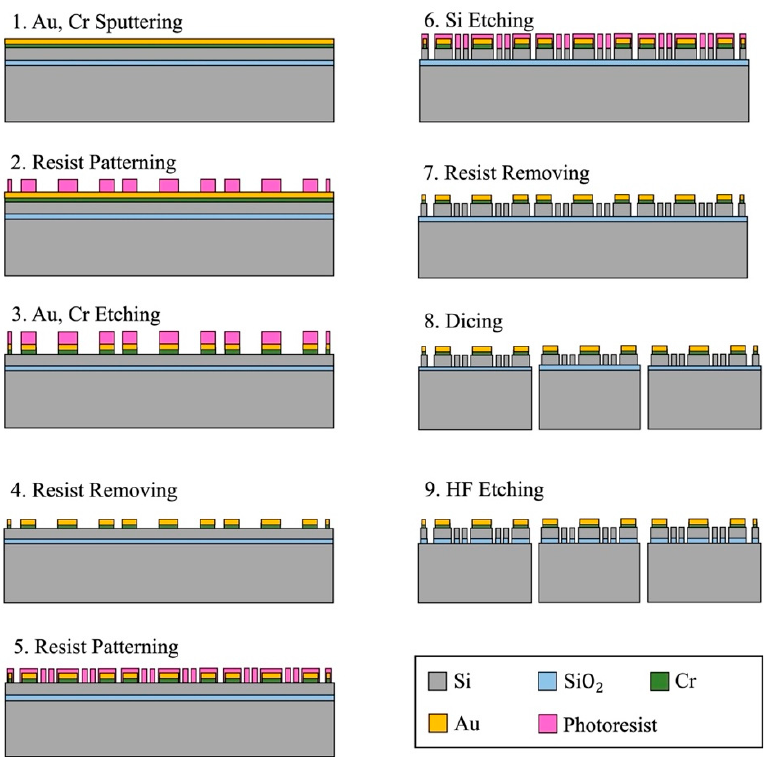
Figure 9. Schematic flow of MEMS manufacture process for the resonators, which was developed based on the standard SOI process.